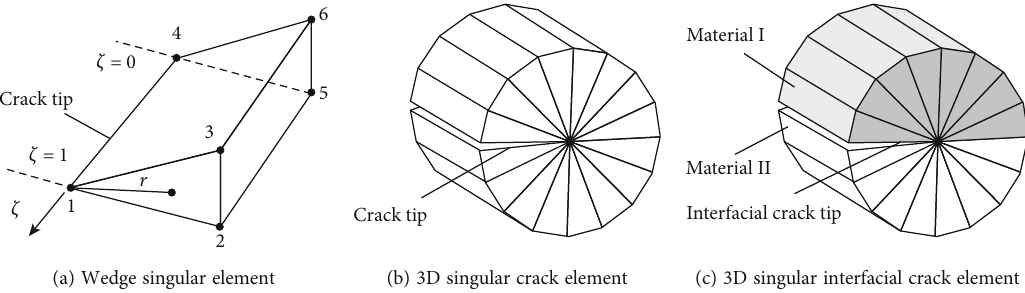
Figure 1: Building 3D singular crack element and singular interfacial crack